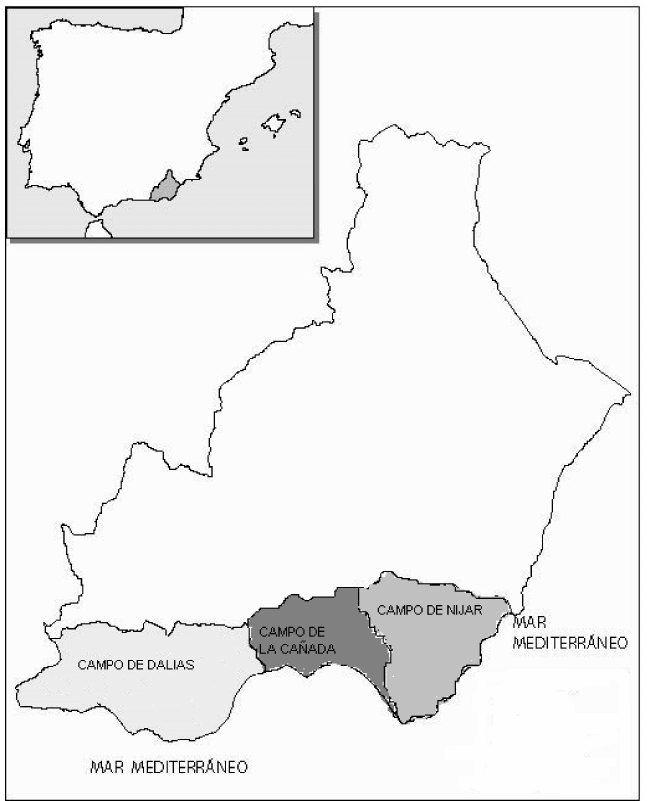
Figure 1. Almer í a, polled areas. Compiled by the